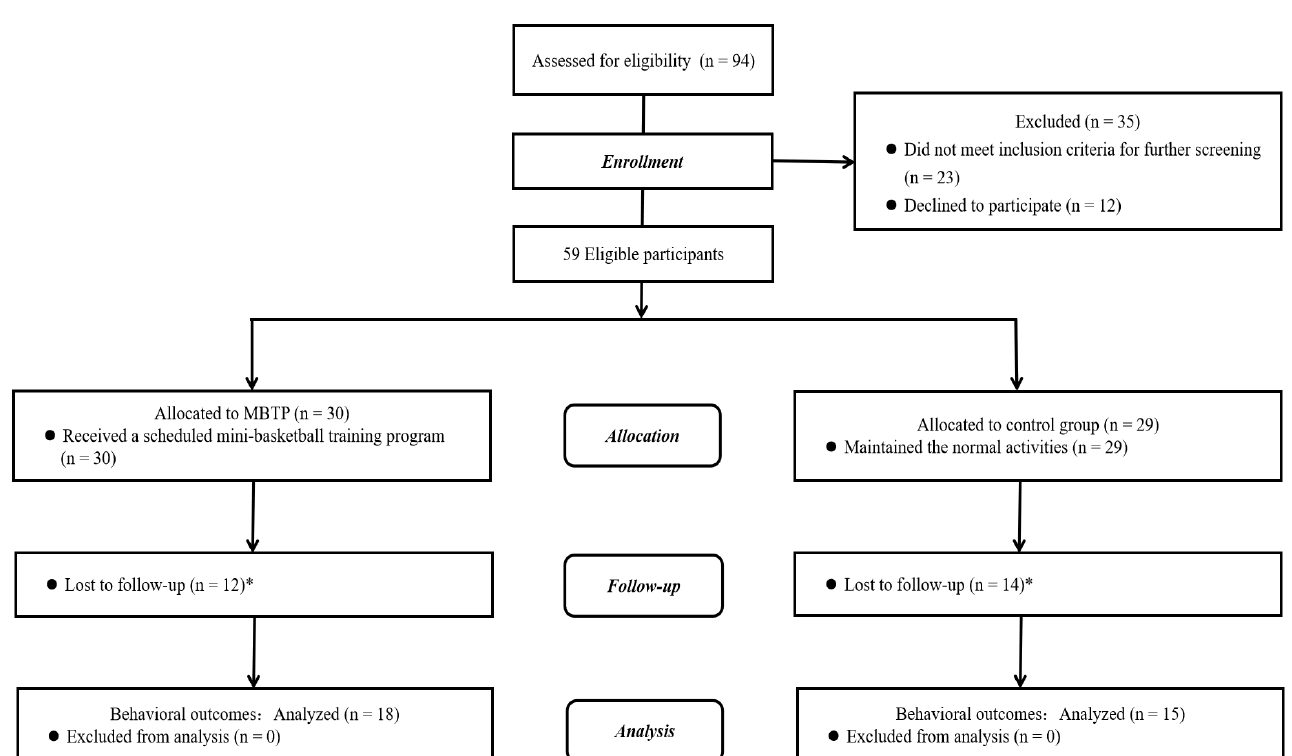
Figure 1. Participant flow chart. * Twenty-six children’s parents did not finish the assessment in the post-test.